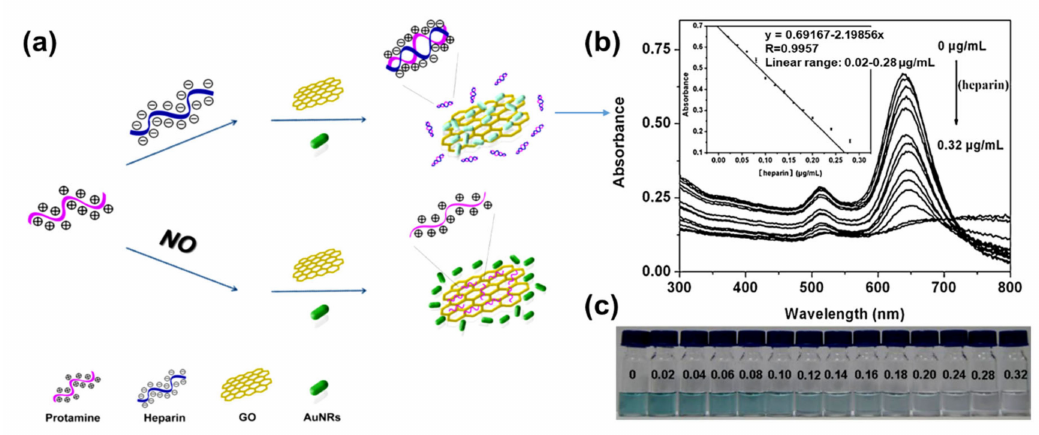
Figure 12. ( a ) Schematic of GO–AuNRs protamine mixed sensor for detecting heparin. ( b ) Absorption spectra of GO–AuNRs protamine mixed solution with di ff erence heparin concentrations. Inset: heparin detection calibration curve ( c ) Photographic images of the corresponding colorimetric responses with the increase of heparin concentration. Adapted from [43], with permission from Elsevier,